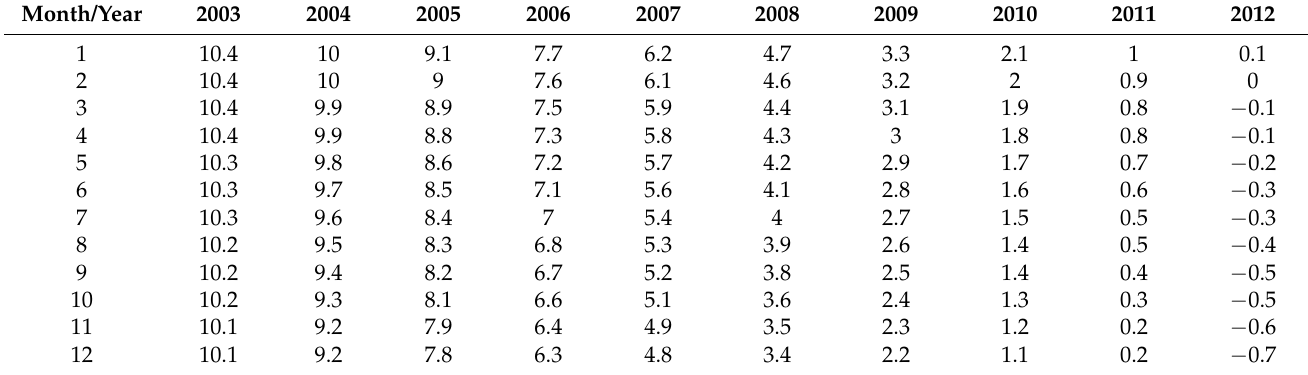
Table A3. Trend (fifth-order polynomial) determined for the February-March period for all years and extrapolated onto the rest of the data; Xco